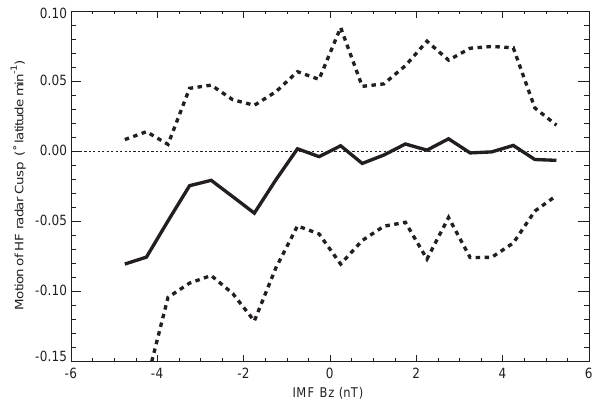
Fig. 4. The average motion of the HF radar cusp as a function of the prevailing IMF B Z component (solid line). The dashed lines repre- sent ± 1 standard deviation of the distribution of latitude variation values. Only averages where more than 25 data points per bin were available are